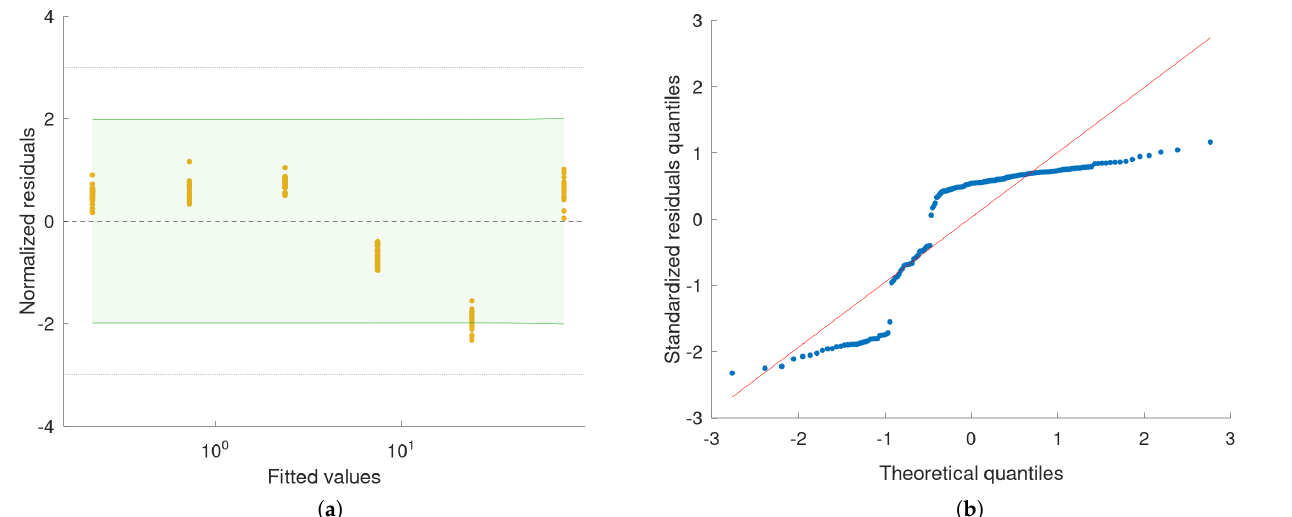
Figure 13. ( a ) Scatter plot of the normalised residuals (residuals divided by the standard deviation, σ = 60.2 nm) vs. fitted values from the linear regression model. Shapiro–Wilk test for normality of residuals distribution: p = 1.76 × 10 − 15 indicates this distribution should not be assessed as normal. Deviations of the data points from the model might be interpreted as a graphical representation of the probe non-linearity. Dashed lines indicate the ± 3 σ zone. The green–shaded area represents the 95% prediction interval for a new observation based on the obtained model. ( b ) Quantile–quantile plot of the estimated residuals’ distribution against the normal distribution. The visible deviation of the sample distribution from normality confirms the low value of the Shapiro–Wilk test. Table 2. Typical budget for calculating the uncertainty of roundness measurements adapted for the considered study of roundness instrument. Uncertainty Contribution Quantity in nm Instrument resolution 4 Uncertainty of determining the depth of the 17 to 19 groove (from simulated grooves) Groove measurement repeatability for each groove nm * * For each simulated groove the standard deviation were 0.24 µ m (8.8 nm); 0.74 µ m (9.6 nm); 2.4 µ m (8.0